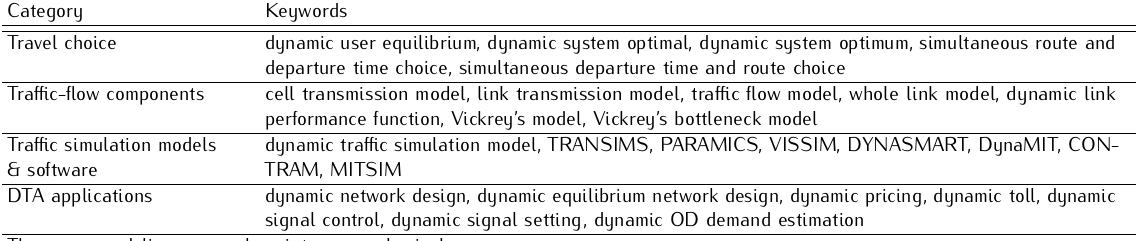
Table 1. Keywords used for literature review. Category Travel